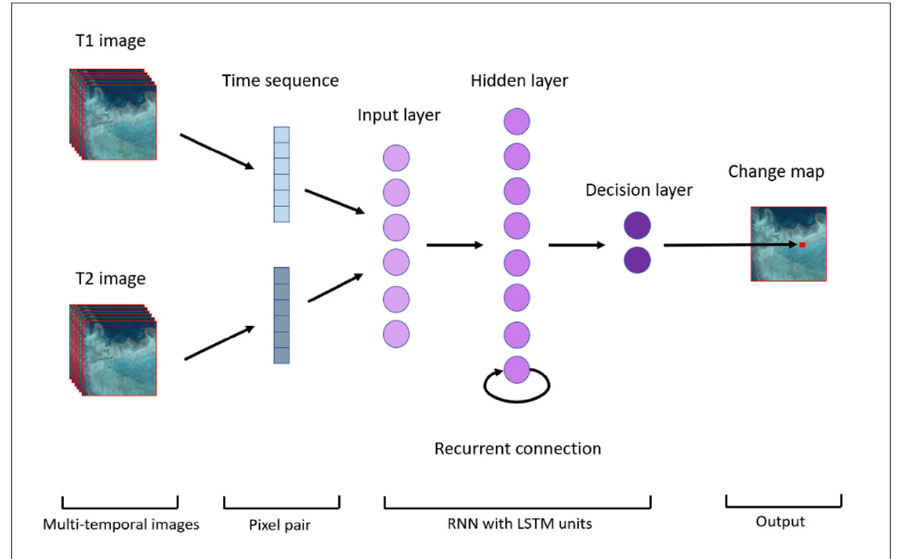
Figure 11. Illustration of the RNN-LSTM framework developed by Lyu et al. [34], which they refer to as REFEREE. The hidden layer consists of LSTM units as illustrated in Figure 10. This illustration is based on the illustration in Figure 4 depicted in Lyu et al. [34].